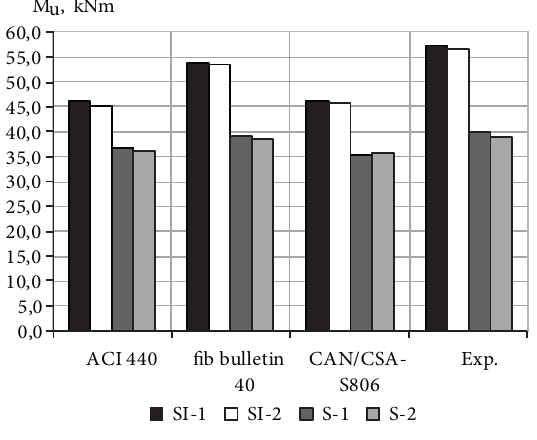
Fig. 3. A comparison of experimental and theoretical flexural